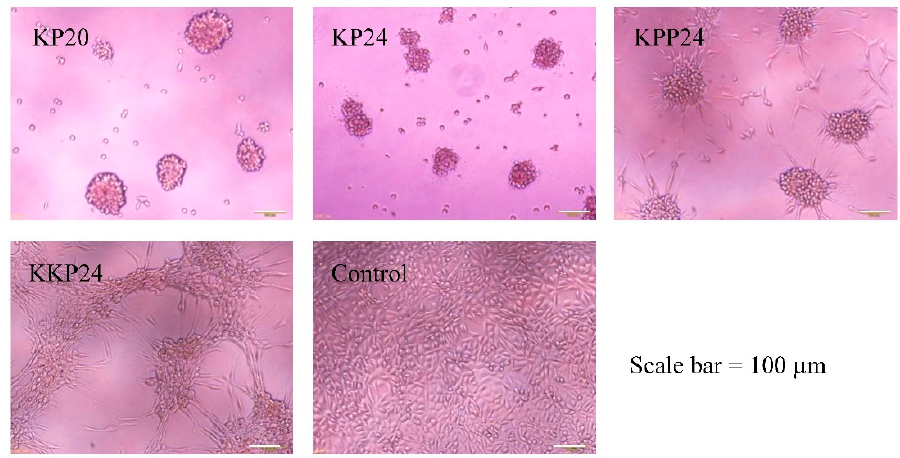
Figure 2. Effect of peptide sequence on inducing cell aggregation (day 6). Cell density, 5.0 × 10 4 cells/mL; peptide concentration, 1.0 mg/mL; scale bar: 100 μ m.